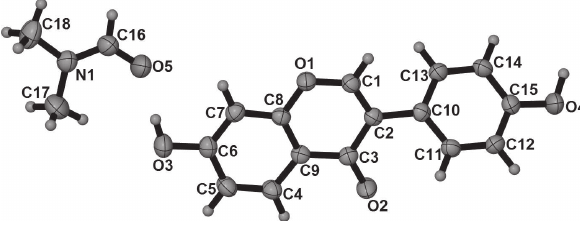
Table 1: Data collection and handling.